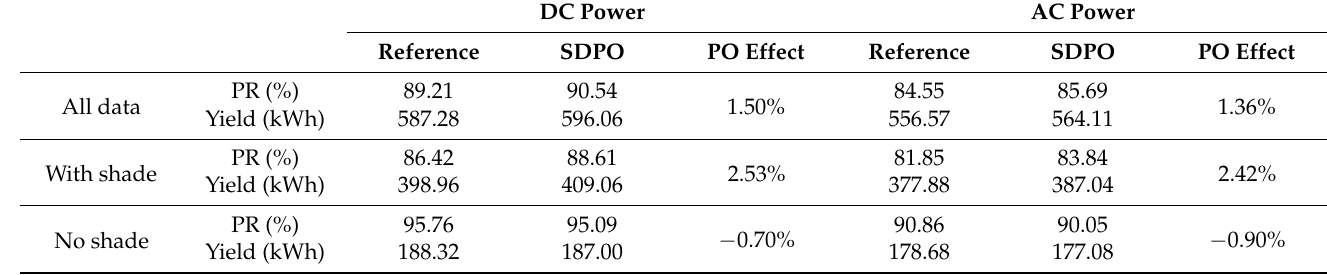
Table 2. PR and AC yield for shade, unshaded and mixed period.